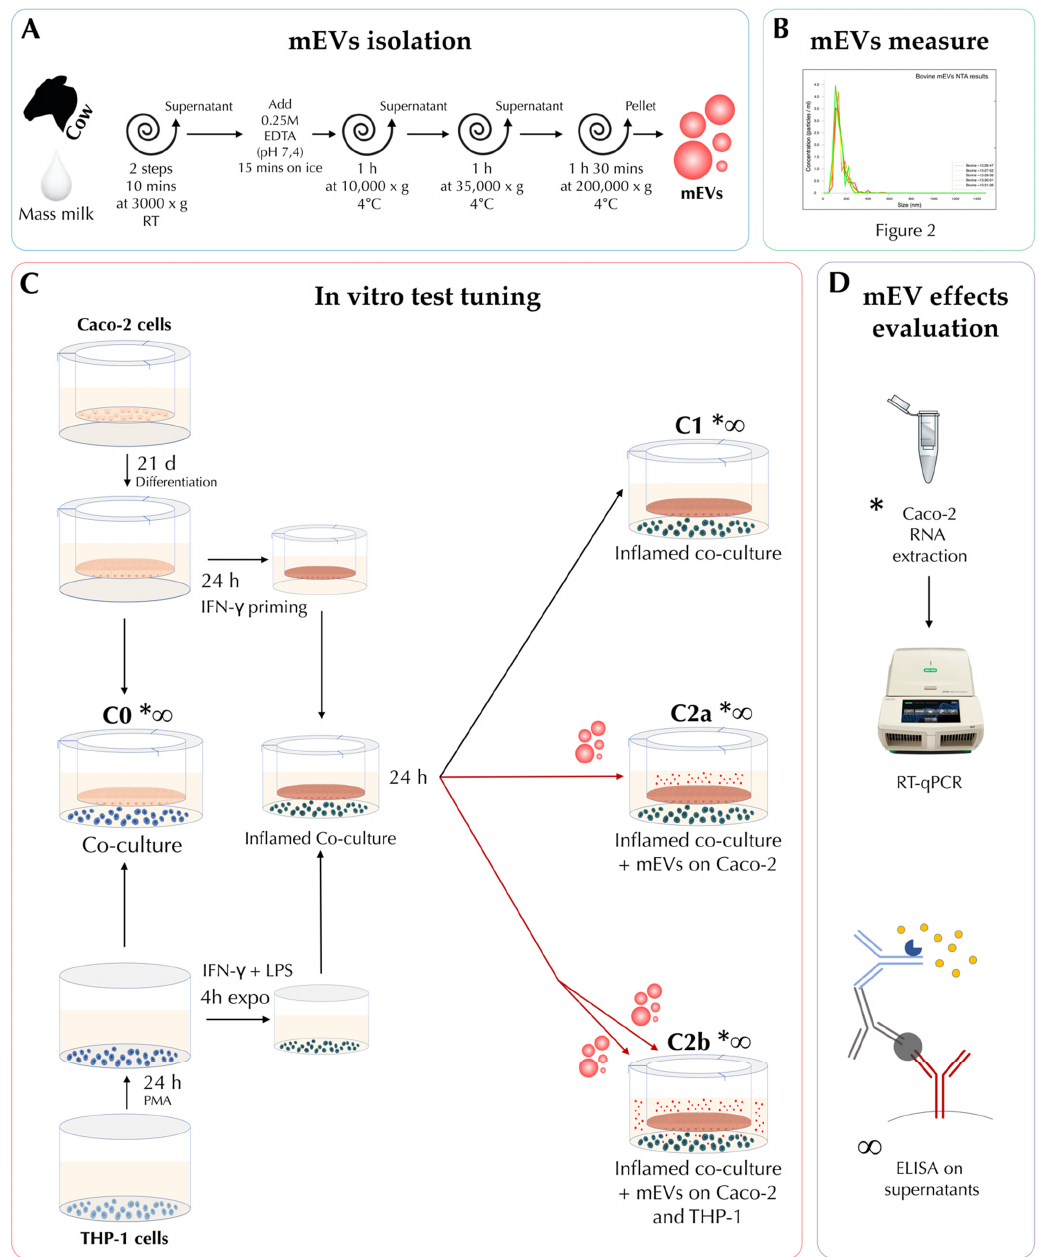
were used within a week from the isolation.